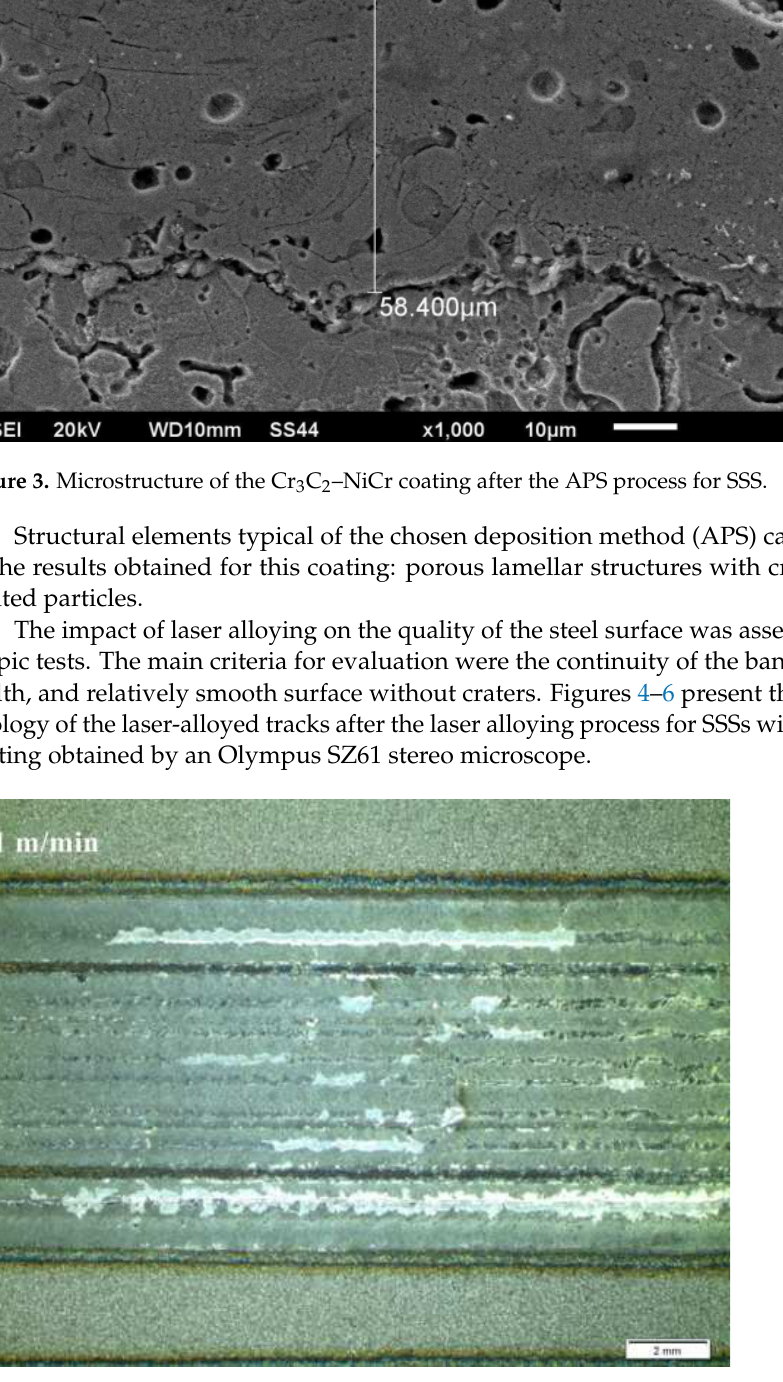
Figure 5. Morphology of the laser-alloyed tracks of surface of SSSs for sample 2. Figure 6. Morphology of the laser-alloyed tracks of surface of SSSs for sample 3. The metallographic section was prepared, which was etched with copper sulfate so- lution. Figures 7–9 show a fragment of the microstructure of the laser stitch obtained after the laser alloying treatment of the Cr 3 C 2 –NiCr coating (the image was obtained using the Olympus GX41 optical microscope).